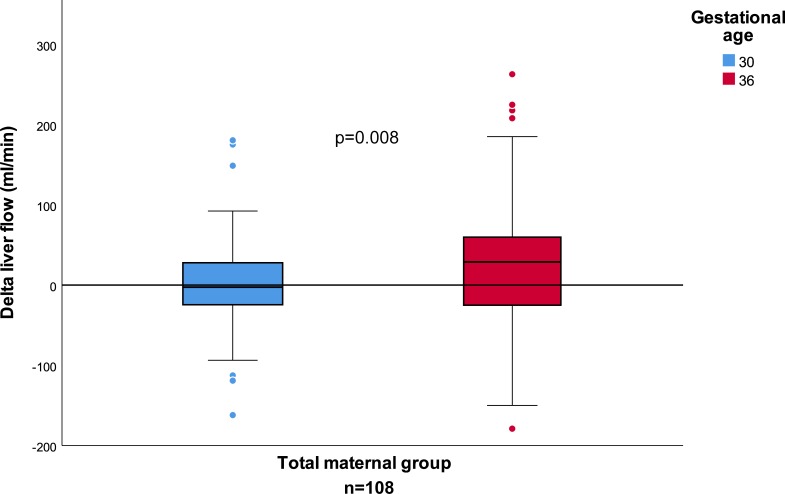
Change in fetal liver blood flow in gestational weeks 30 and 36 for the total maternal group.Box-plot shows the Δliver blood flow at 30 (blue) and 36 (red) weeks of gestation. There was a significant positive change in Δliver flow from weeks 30 to 36.